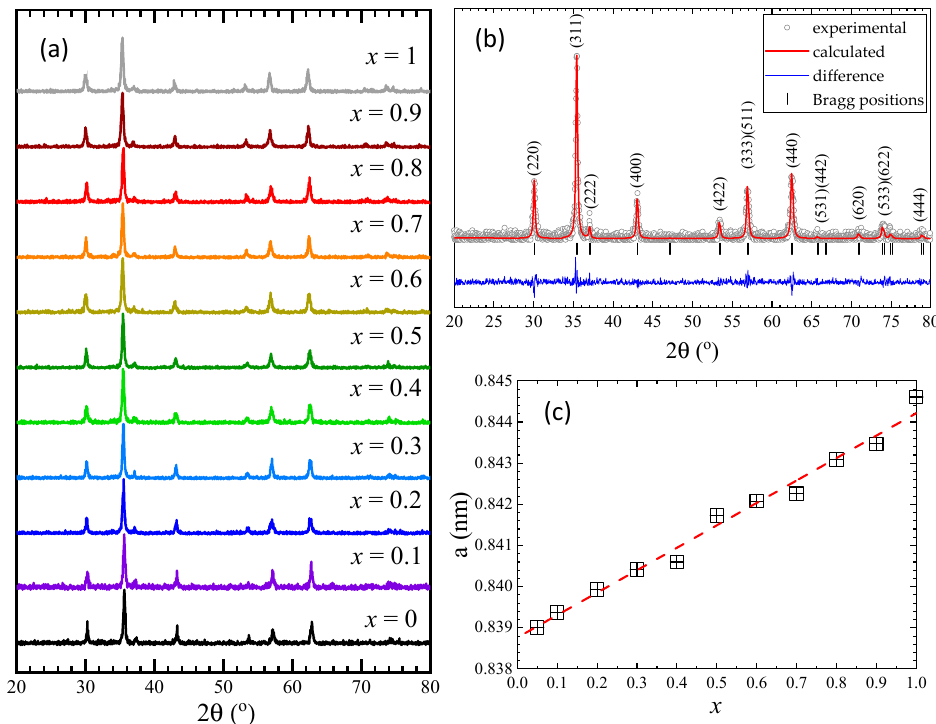
Figure 1. ( a ) XRD patterns at room temperature of Co 1 − x Zn x Fe 2 O 4 nanoparticles, ( b ) Rietveld refinement results for Co 0.7 Zn 0.3 Fe 2 O 4 , ( c ) The lattice parameter/unit cell volume dependence with Zn concentration for Co 1 − x Zn x Fe 2 O 4 . Table 1. Structural parameters and Rietveld agreement factors, such as weighted profile factor (R wp ),